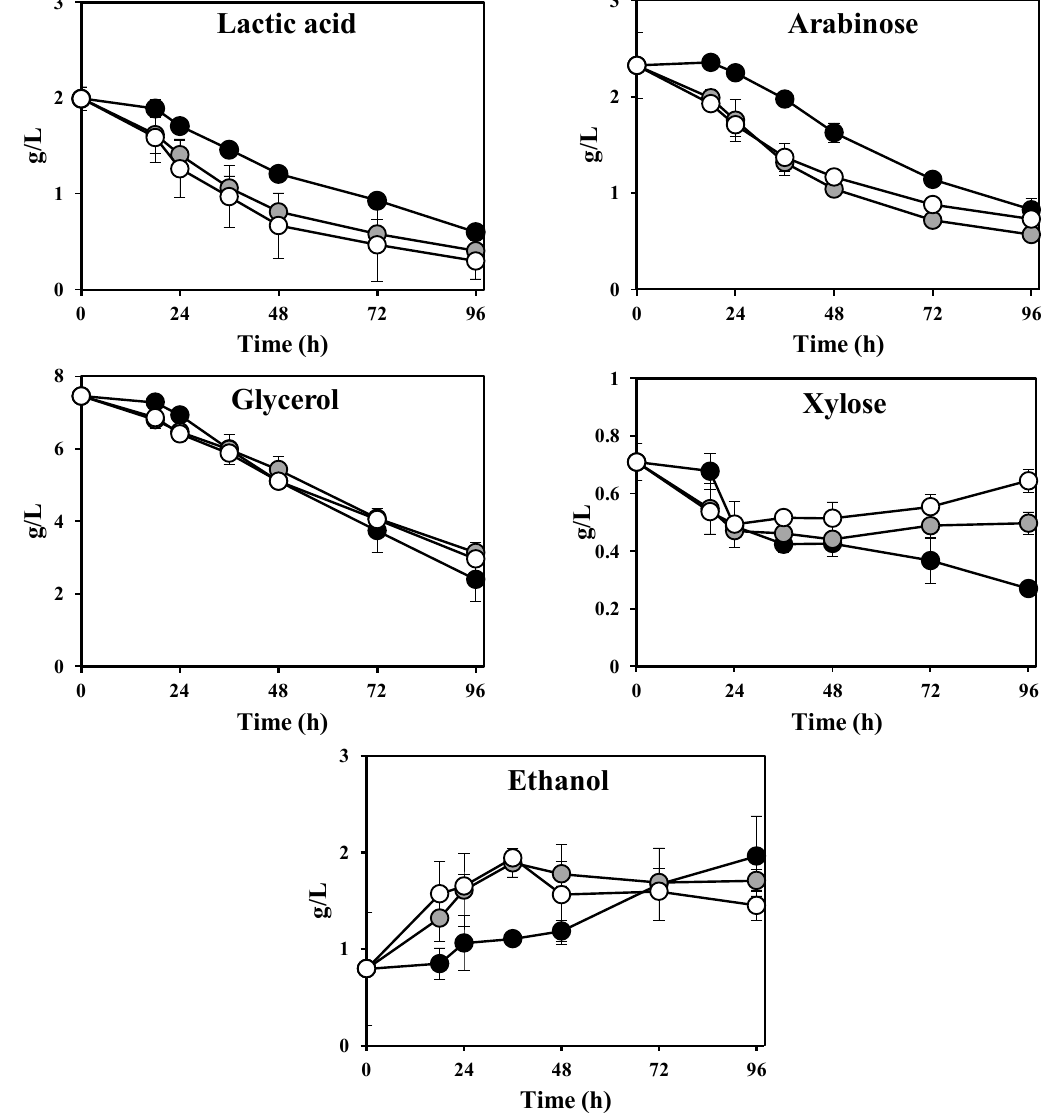
Figure 3. Concentration of lactic acid, glycerol, ethanol, arabinose and xylose during cultivation of Rhizopus sp. in thin stillage at 30 °C (black), 35 °C (grey) and 40 °C